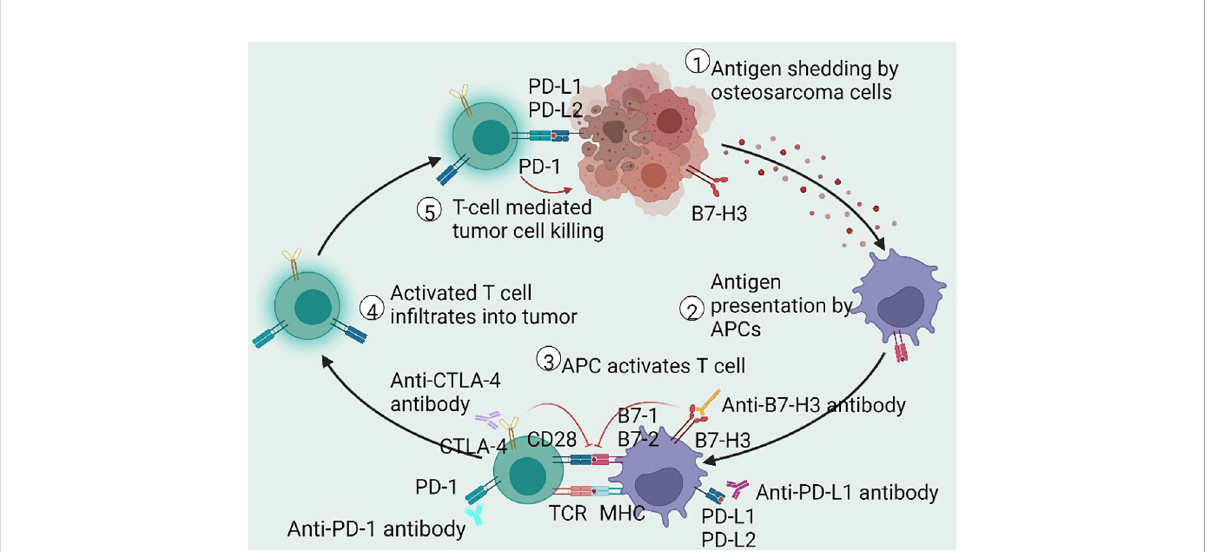
FIGURE 2 Schematic of antitumor immune cycle. The immune cycle starts from the production of neoantigens in dying or dead OS cells, endocytosed by APCs for presentation or cross-presentation on MHC. Then, the antigen-loading APCs migrate to the draining lymph nodes to activate antigen- speci fi c T cells. Activated T cells then in fi ltrate the tumor cells to drive adaptive immune response and to restrain tumor growth. These antitumor immune responses are modi fi ed by immune checkpoint mechanisms. The interaction of PD-1 and PD-L1 inhibits intracellular signaling pathways on T cell activation, whereas CTLA-4 prompts inhibitory effects by competitively depriving CD28 ligand and mechanistically binding B7 molecules. Antibodies that affect ICIs may sustainably stimulate the antitumor immune response in patients with OS. OS, osteosarcoma; APCs, antigen-presenting cells; MHC, major histocompatibility complex; PD-1, programmed cell death receptor-1; CTLA-4, cytotoxic T lymphocyte-associated protein 4; B7-H3, B7 homolog 3; PD-L1/PD-L2, programmed cell death receptor-1/2 ligand; ICIs, immune checkpoint